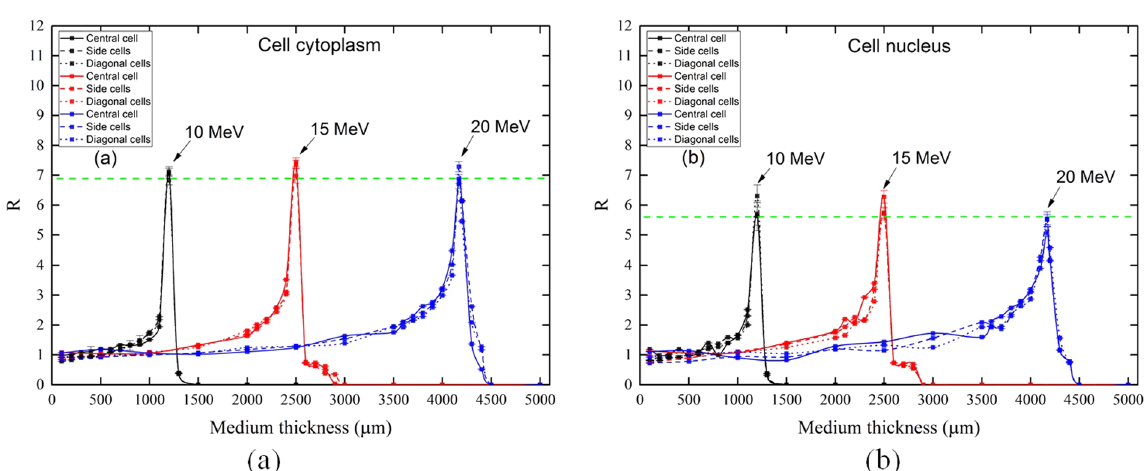
Figure 5. Variations of calibration coefficient R in ( a ) cytoplasm and ( b ) nucleus of cells for proton with incident energies of 10, 15 and 20 MeV, showing the maximum R values. (The lines connecting the points do not represent data and are only presented to help the eye). (Note: error bars are smaller than the